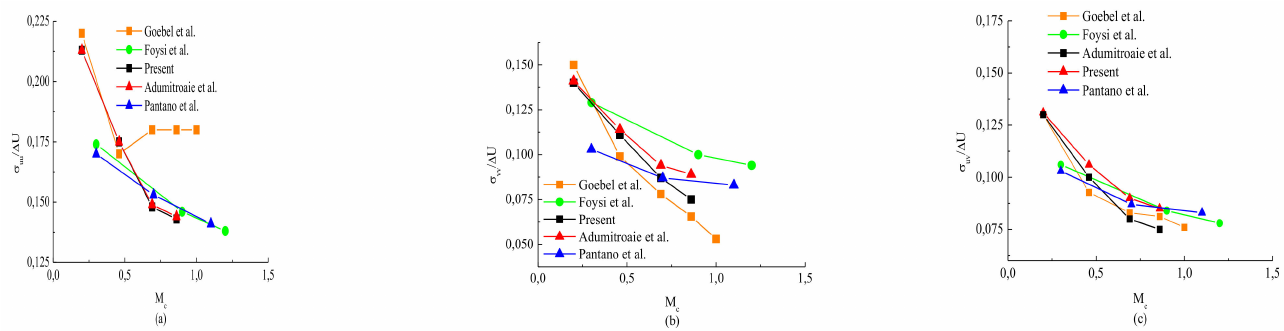
nents: ( b 11 ) max, ( b 22 ) max and ( b 12 ) max versus convective Mach number computed